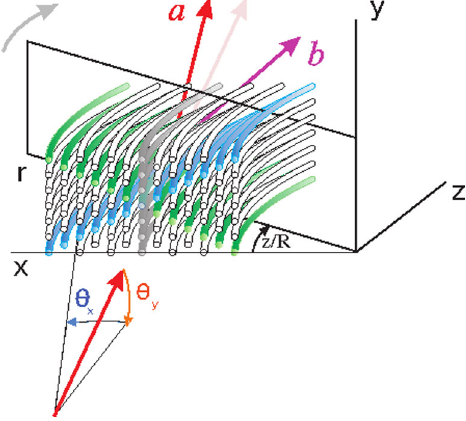
FIG. 6. Multiple volume reflection in one bent